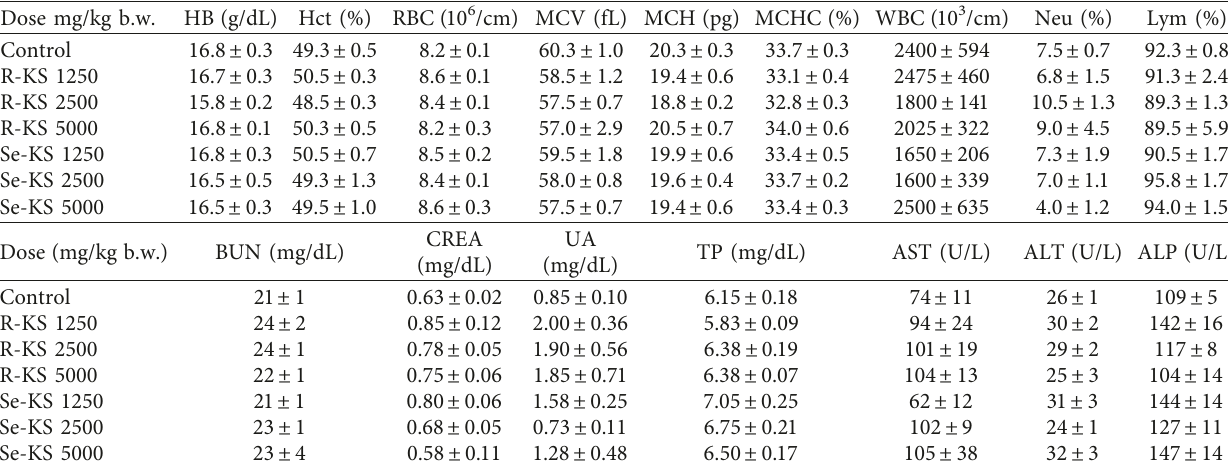
∗ Significant model difference at p < 0 . 05. ∗∗ Significant model difference at p < 0 . 01. PC � protein contents; Se-bio � Se bioaccessibility; TSeC � total Se contents; TPC � total polyphenol contents; TFC � total flavonoid contents. Table 4: Hematological and biochemical values of rats treated with Chinese kale seedlings for acute toxicity administration. Dose mg/kg